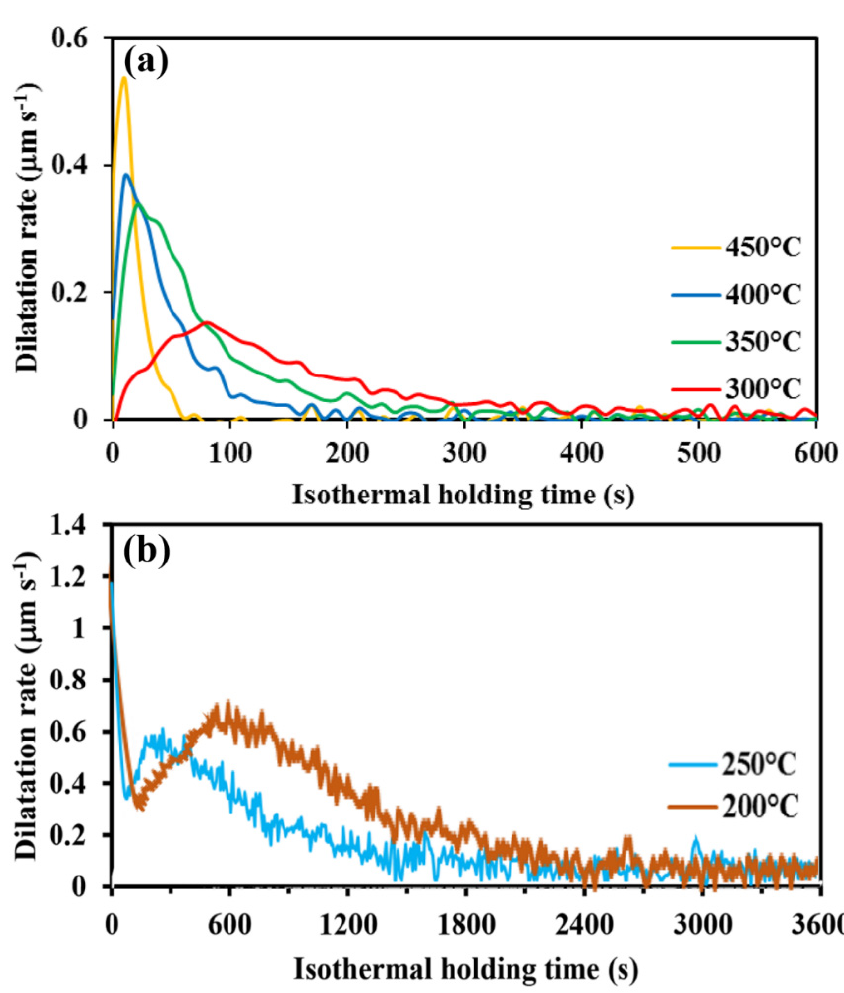
Figure 7. Dilation rate curves as a function of holding time during treatment in ( a ) Q&B and ( b ) Q&P conditions.